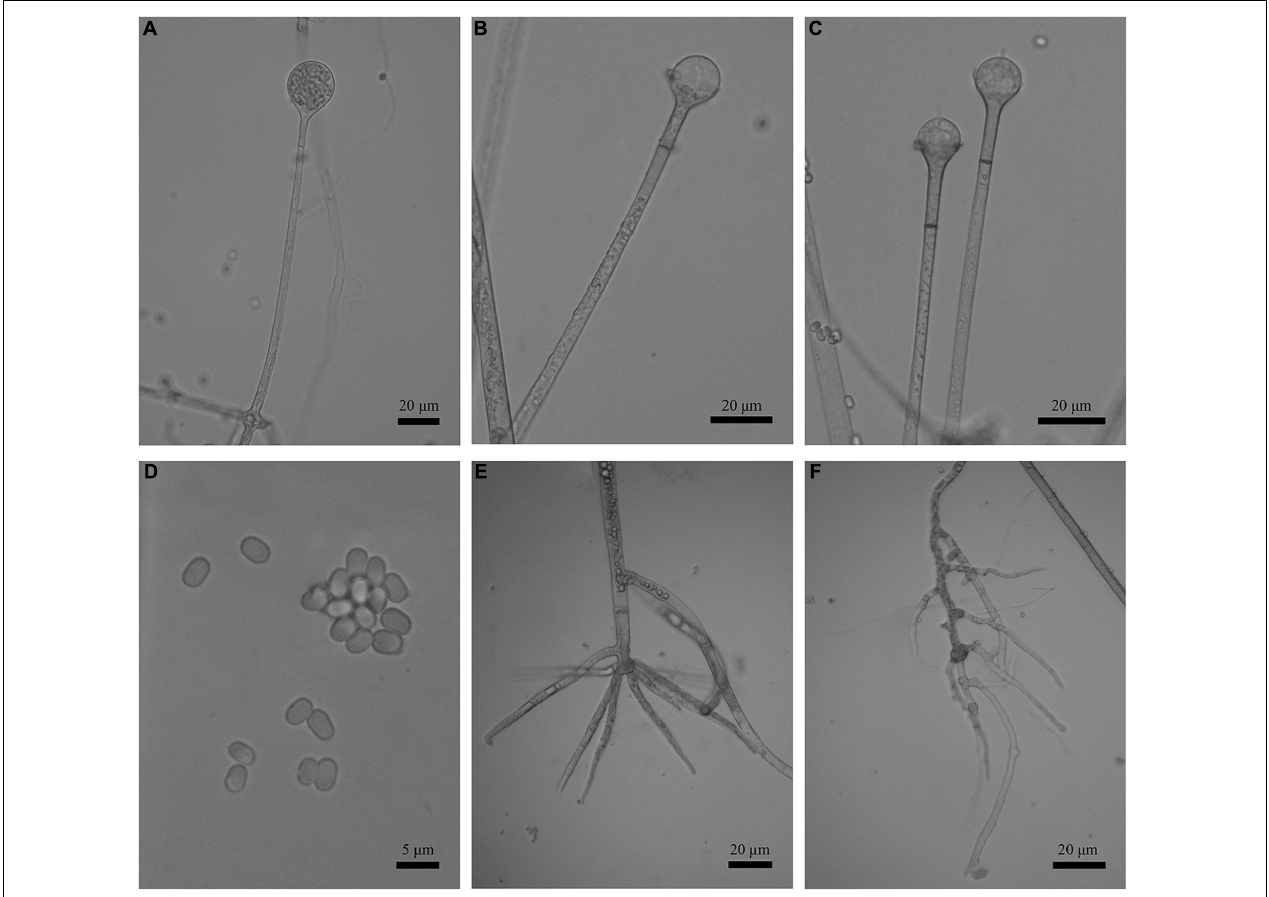
FIGURE 5 | Morphologies of Absidia medulla CGMCC 3.16034. (A) Sporangium; (B,C) columellae; (D) sporangiospores; (E,F) rhizoids. Scale bars: (A–C,E,F) 20 µ m; (D) 5 µ m.